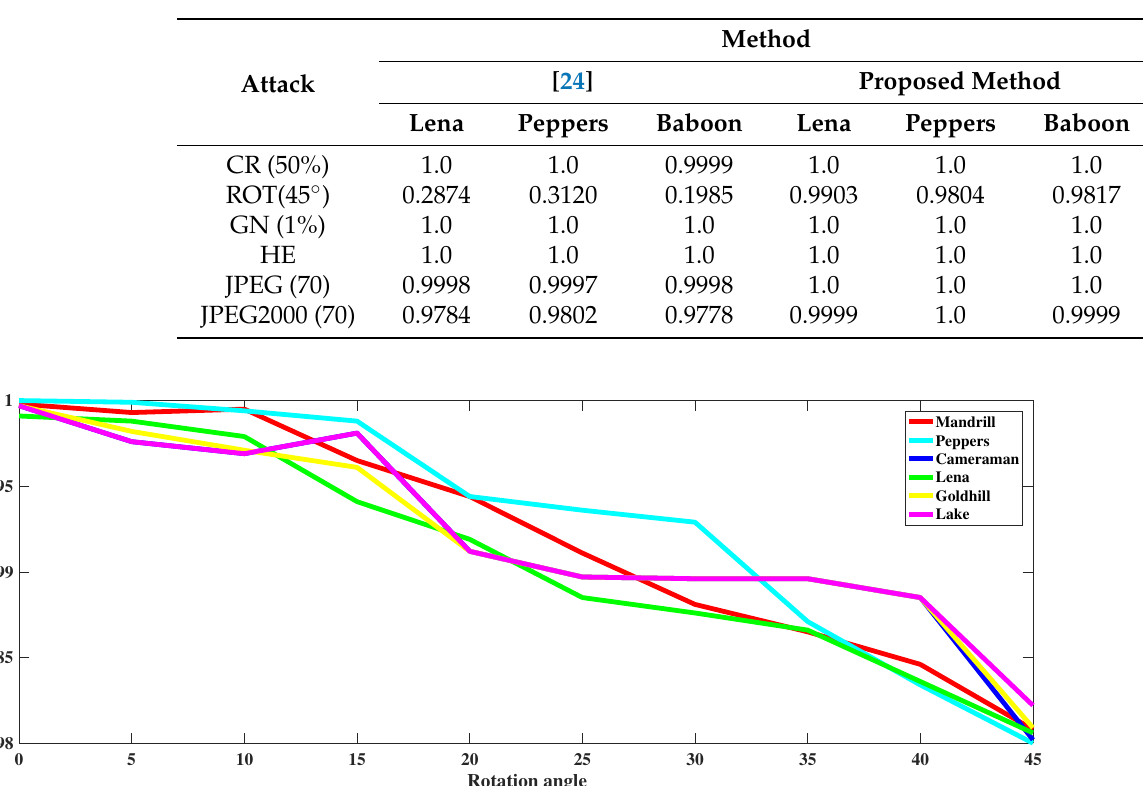
Table A6. Robustness comparison with [24] measured in terms of NC for Lena, Peppers, and Baboon images.